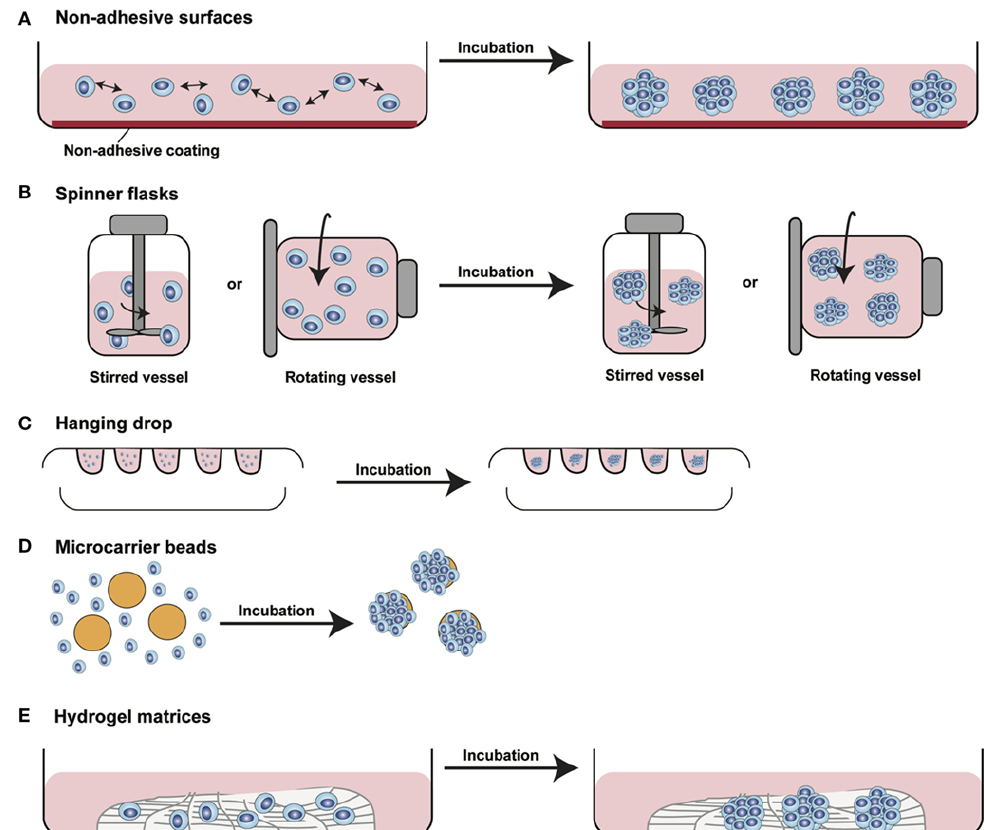
Figure 3. Diagram showing different approaches used to develop 3D spheroids. ( A ) Non-adhesive surfaces: modified culture plates with reduced surface adhesive force allows spontaneous cell aggregation to form cellular spheroids, ( B ) Spinner flasks or gyratory rotator: continuous medium mixing or a constant flask rotation prevents cell adhesion causing massive production of 3D spheroids, ( C ) Hanging drop method: cells suspended in small drops onto the underside of an inverted hanging drop plate induces accumulation of spheroidal aggregates due to gravity forces, ( D ) Microcarrier beads: solid beads of natural or synthetic origins allows surface coating to produce minispheroids that subsequently aggregate to form bigger spheroids, ( E ) Hydrogel matrices: natural or synthetically composed hydrogels are incubated with the cells for their aggregation [This figure is adopted with permission from Manuela et al., 2017 [44]].